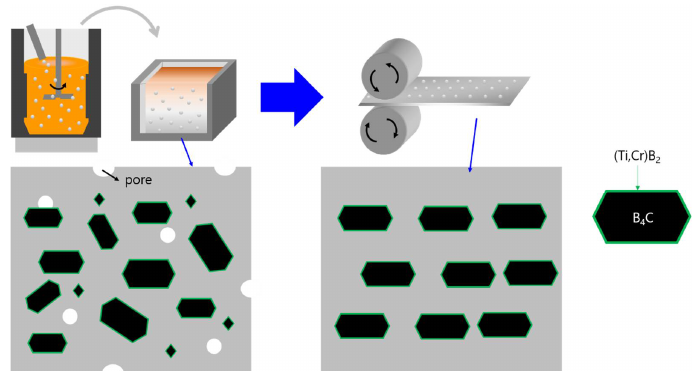
Figure 4. Schematic diagram of the porosity and reinforcement arrangement of B 4 C/Al6061 composites according to pro- cess.